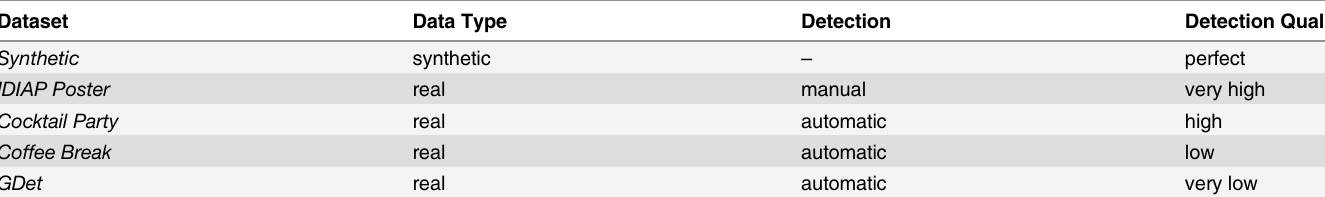
Table 3. Summary of the features of the datasets used for